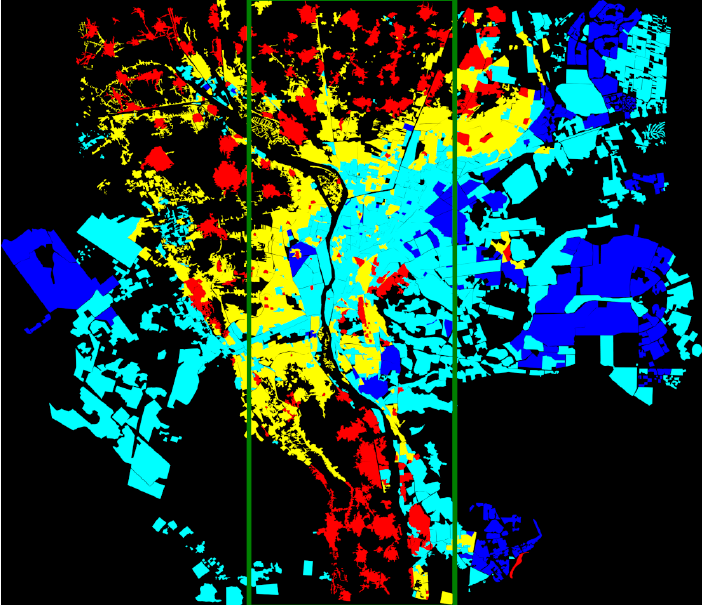
Figure 6. Ground truth for building categorization in Cairo. Red: highly informal area (arrival city); green: moderate informal area; cyan: moderate formal area; blue: formal area; black: uninhab- ited